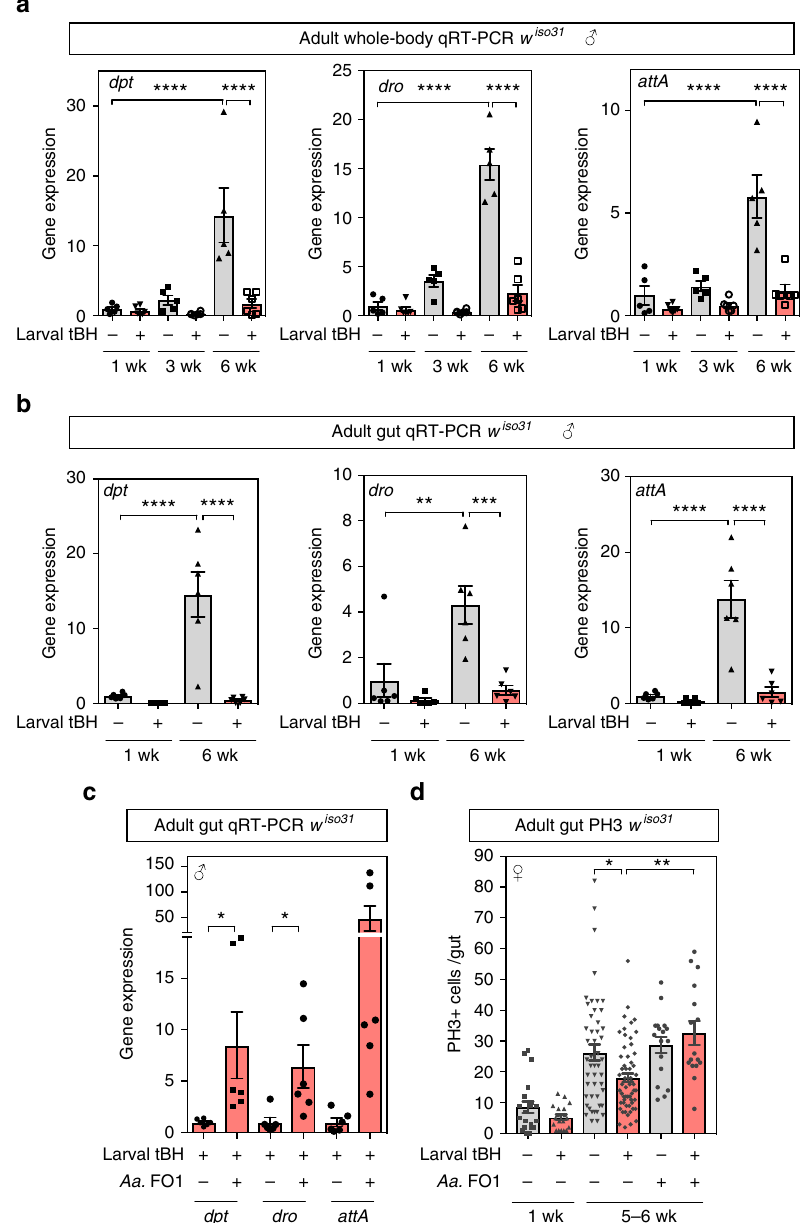
Fig. 8 Depletion of A. aceti suppressed age-related intestinal dysregulation. a , b Quantitative RT-PCR for three IMD target genes ( dpt , dro and attA ) in whole body ( a ) or gut ( b ) of w iso31 male fl ies at 1, 3 and 6 weeks of age. Mean ± SEM ( n = 6). c Quantitative RT-PCR of the three IMD target genes in guts from tBH-experienced w iso31 male fl ies at 5 weeks of age, with or without reassociation with A. aceti FO1. Mean ± SEM ( n = 6). d The number of phospho- histone H3-positive (PH3+) cells in the midgut of w iso31 male fl ies with or without reassociation with A. aceti FO1. Mean ± SEM (from left to right n = 20, 19, 48, 59, 17 and 16). * p < 0.05, ** p < 0.01, *** p < 0.001, **** p <